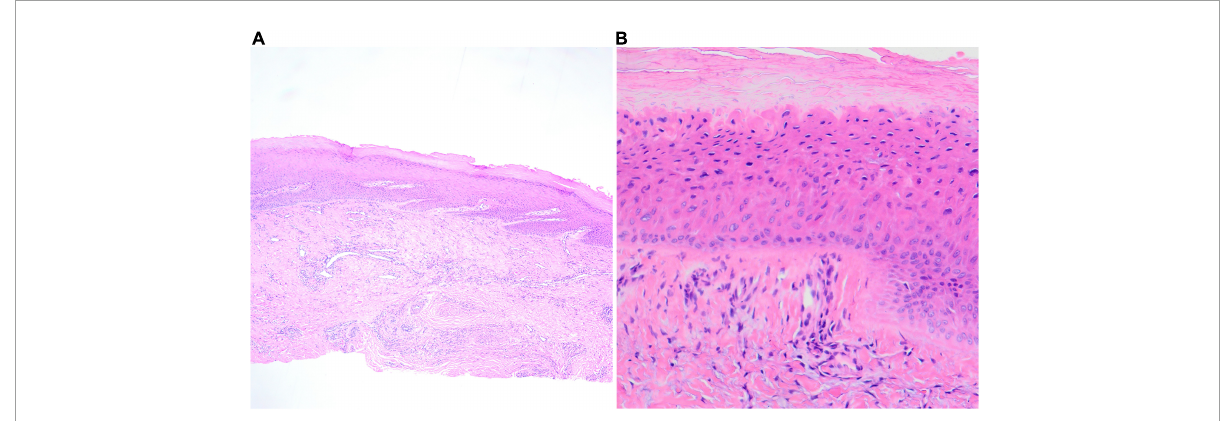
FIGURE2 Longitudinal sections; the pathological features of onychopapilloma. (A) Papillomatosis of the distal nail bed epithelium (HE, × 100). (B) The scanning magnification shows the upper layers of the nail bed contains cells resembling those of the keratogenous zone of the matrix (HE, × 400).